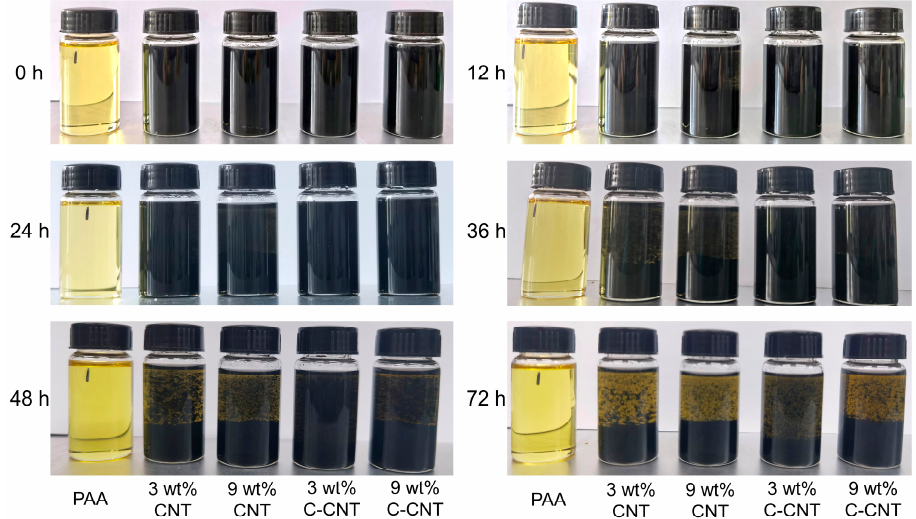
Figure 6. Comparison of photographs of CNT and C-CNT dispersed in solution for different hours.